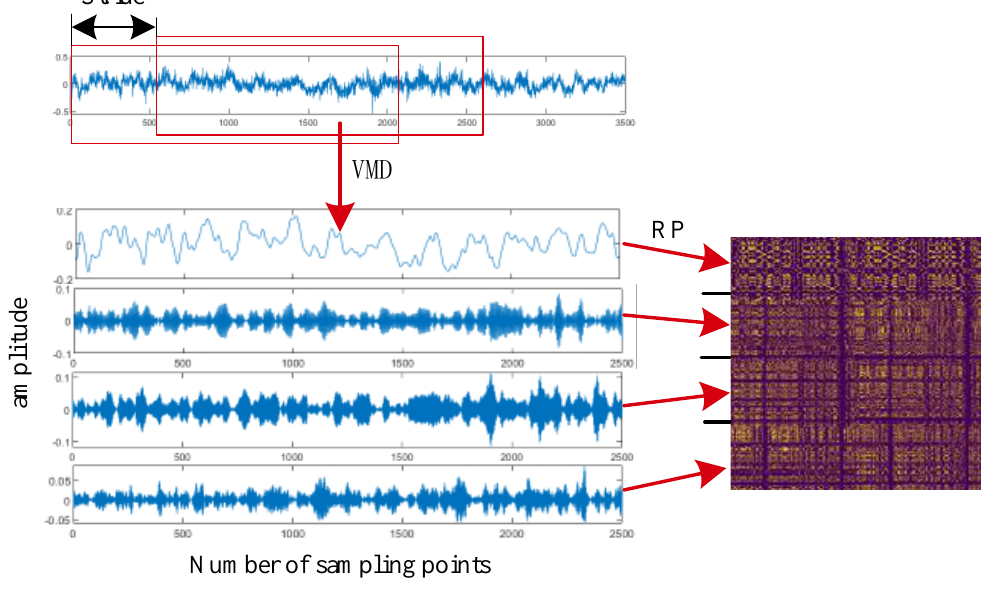
Table 1. Dataset specific division. Figure 7. Data interception schematic. Figure 7. Data interception